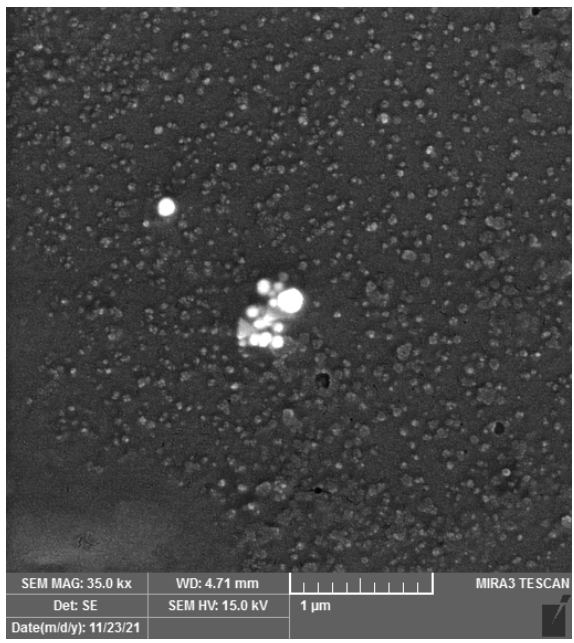
Figure 2. FESEM image of Au NPs synthesized by E. coli TOP-10.